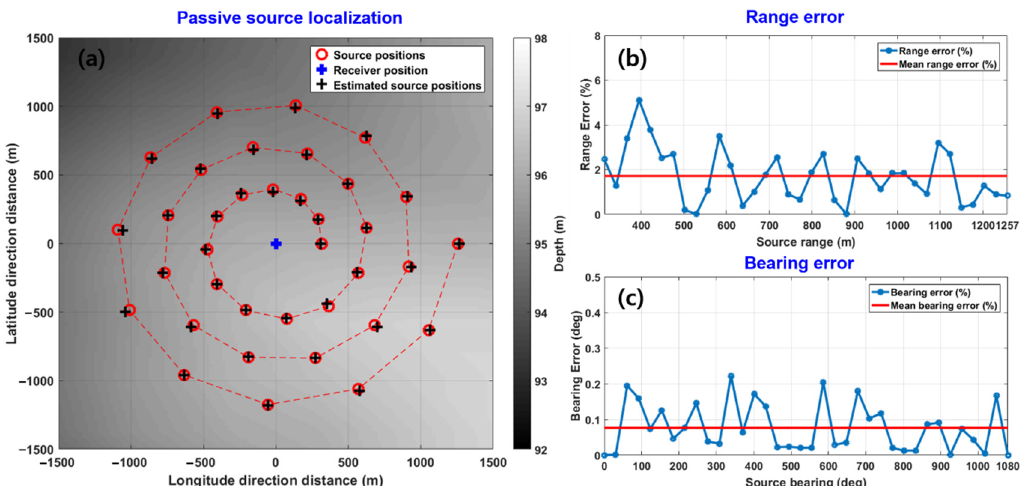
Figure 3. ( a ) Horizontal and vertical active intensity envelopes calculated from the simulated particle velocities for given simulation scenarios and ( b ) beam-time migration estimated for the multipaths. The vertical axis of ( b ) represents the beam angle ( s = sin θ ), where a positive value denotes an upgoing wave. The dashed line represents a beam-time migration curve obtained using the best fit value of χ , which is − 2.09.